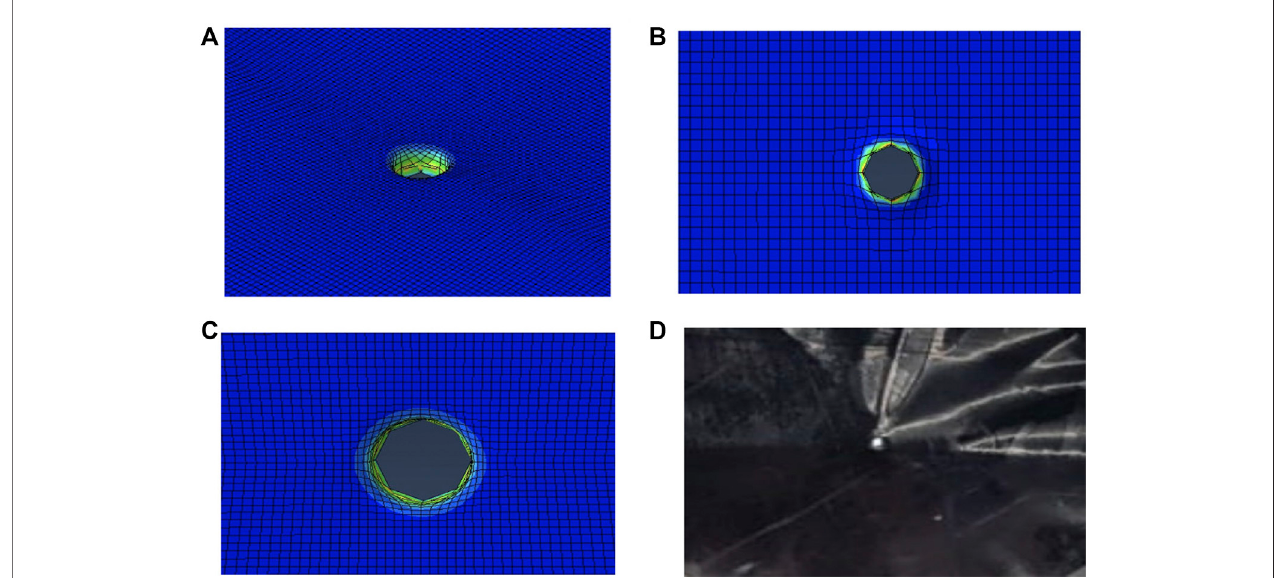
FIGURE 12 | Simulated fracture from (A) Perspective view (B) Bottom View (C) Top view compared to (D) sample after nail